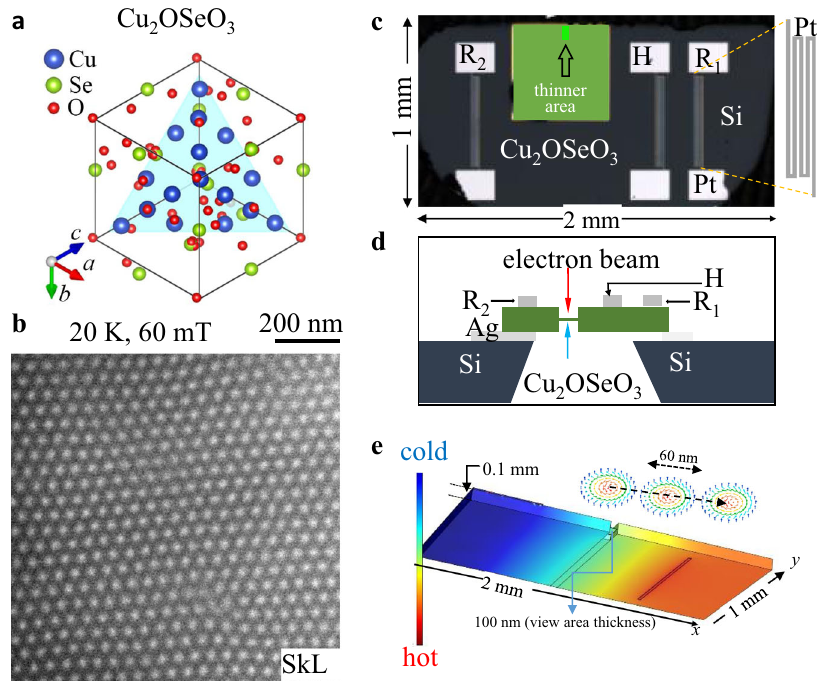
Fig. 1 Thermally driven magnetic skyrmion motion in an insulating magnet Cu 2 OSeO 3 with chiral-lattice structure. a Schematic crystal structure of the Cu 2 OSeO 3 . b A skyrmion (white dot-like contrasts) lattice (SkL) observed by Lorentz transmission electron microscopy (TEM) in a (111) Cu 2 OSeO 3 thin plate under a normal 60 mT fi eld at 20 K. c , d Device con fi gurations ( c topography of the device; d schematic of the device cross-section) for imaging skyrmion dynamics with heat fl ows. e Schematics of skyrmion fl ows in the thin plate with temperature gradients ( ∇ T ). Dashed arrows indicate the anticipated trace of a skyrmion.